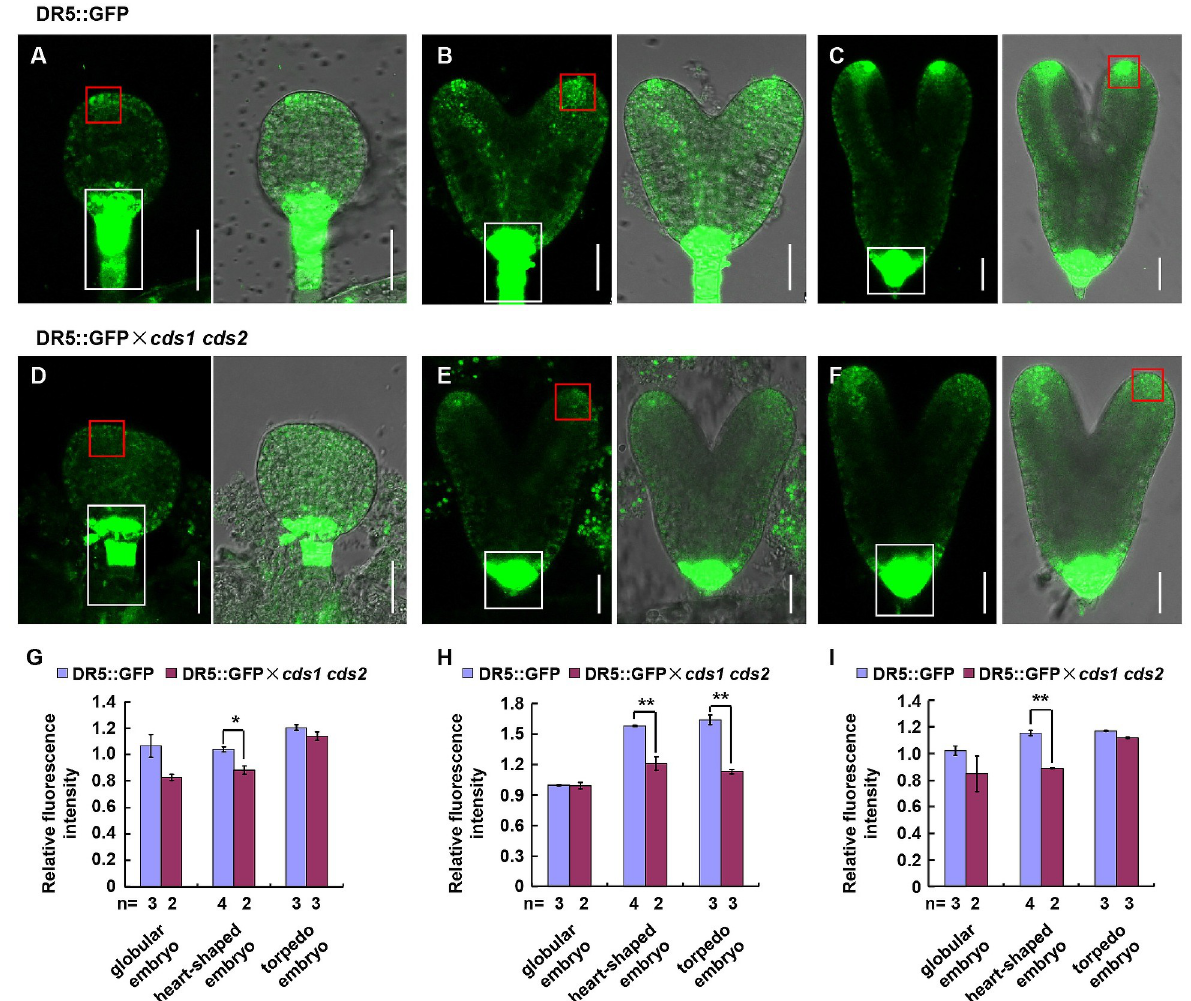
Fig 4. Suppressed expression of CDS1 and CDS2 resulted in altered auxin distribution during embryo development. (A-F) Auxin distribution in embryos at different developmental stages of Col and cds1 cds2 mutant, including globular embryo (A, D), heart-shaped embryo (B, E) and torpedo embryo (C, F). Arabidopsis marker line DR5::GFP or offsprings of DR5::GFP cross with cds1 cds2 (DR5::GFP × cds1 cds2 ) were analyzed. Representative images were shown. Bars = 25 μ m. (G-I) Relative GFP fluorescence intensity of whole embryo (G), cotyledon primordia (H) and hypophysis and suspensor (I) at different developmental stages in DR5::GFP and DR5::GFP × cds1 cds2 . Cotyledon primordia and hypophysis and suspensor are indicated by red or white boxes in A-F, respectively. Analyzed embryo numbers (n) from 2 independent experiments were indicated. Values were mean ± SE. Statistical significance was determined by student’s t test ( � , p < 0.05; �� , p < 0.01).